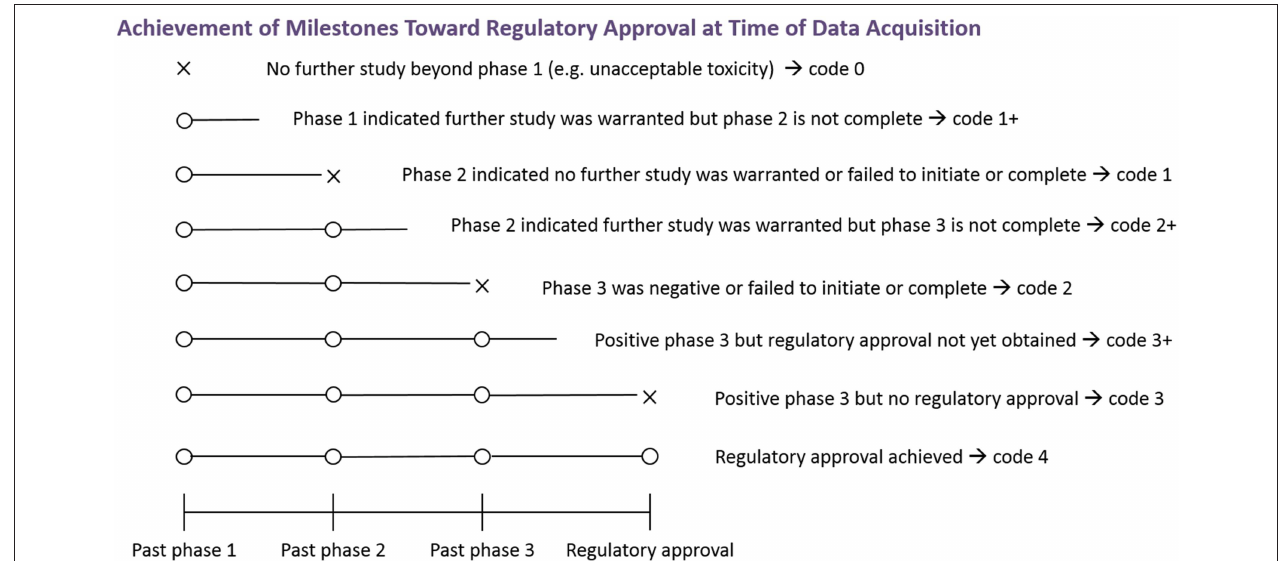
FIGURE 2 | Achievement of milestones toward regulatory approval at time of data acquisition. The figure depicts the endpoint relating to achievement of milestones toward regulatory approval. An X indicates failure at that phase, and an O indicates successful advancement at that phase. An open line indicates that the highest milestone ultimately achieved is not known at the time of data acquisition. To obtain the numerical coding, add the number of Os. Studies of some combinations may be in progress at the time of data acquisition and the highest milestone ultimately achieved is not currently known. Outcomes of such combinations are indicated by a “ +